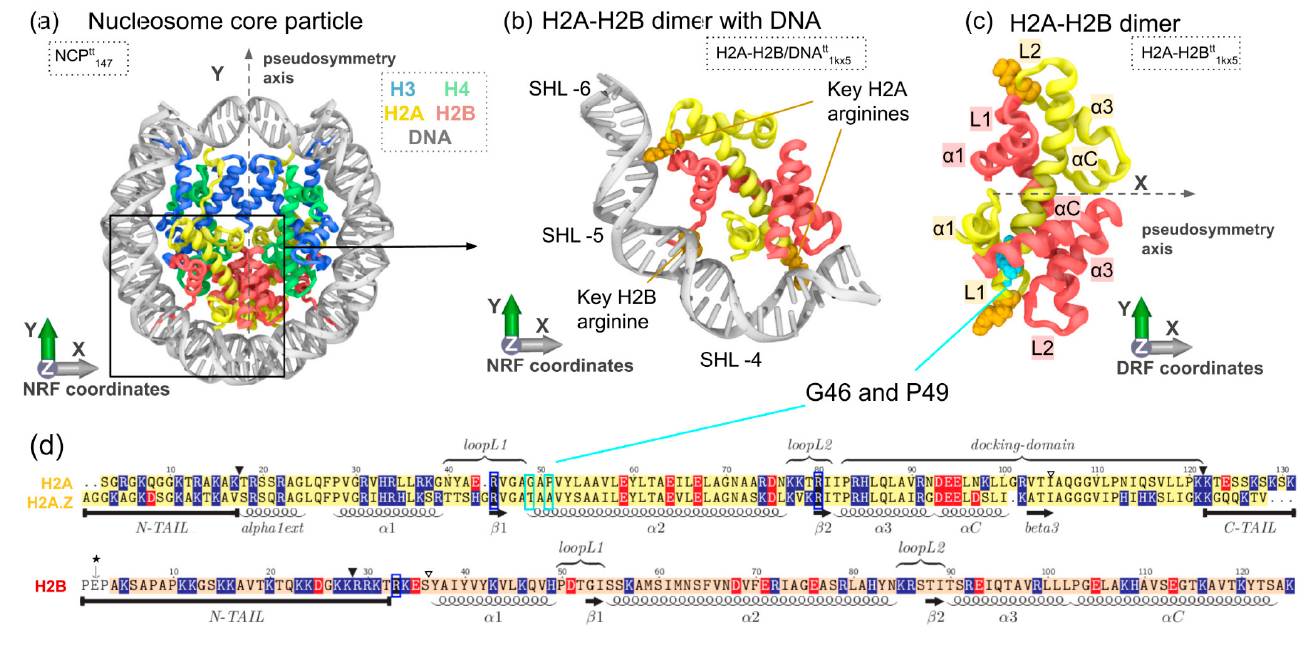
Figure 1. Overview of the nucleosome core particle, H2A-H2B dimer structure, their elements and analyzed systems. ( a ) Nucleosome core particle (NCP). ( b ) H2A-H2B dimer. ( c ) H2A-H2B dimer bound to 30 DNA base pairs, H2A key arginines, which interact with the DNA minor groove on both sides of the H2A α2 -helix, are shown in orange. Introduced reference frames (NRF—nucleosome reference frame, DRF—dimer reference frame) are shown on each panel. ( d ) H2B histone sequence and H2A-H2A.Z sequence alignment ( Xenopus laevis canonical H2A and Homo sapiens H2A.Z). Basic and acidic residues are colored blue and red, respectively. Anchor arginines are highlighted by blue frames. Key structural elements are annotated below or on top of the sequences. Two positions on the alignment (highlighted in cyan frames) correspond to analog positions of H2A/H2A.Z substitutions in yeast affecting nucleosome stability and SWR1 activity [39,40]. ▼ and ▽ mark the histone tails’ truncation sites in NCP and dimer systems’ simulations, respectively.